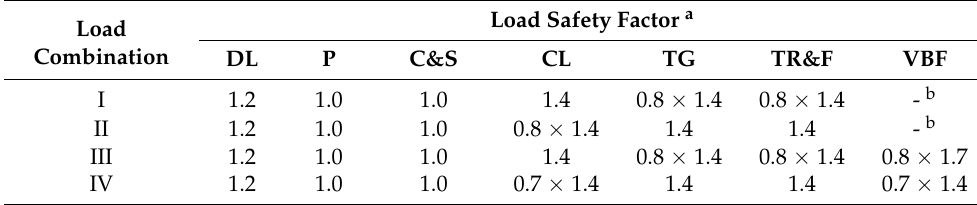
Table 5. Load combination